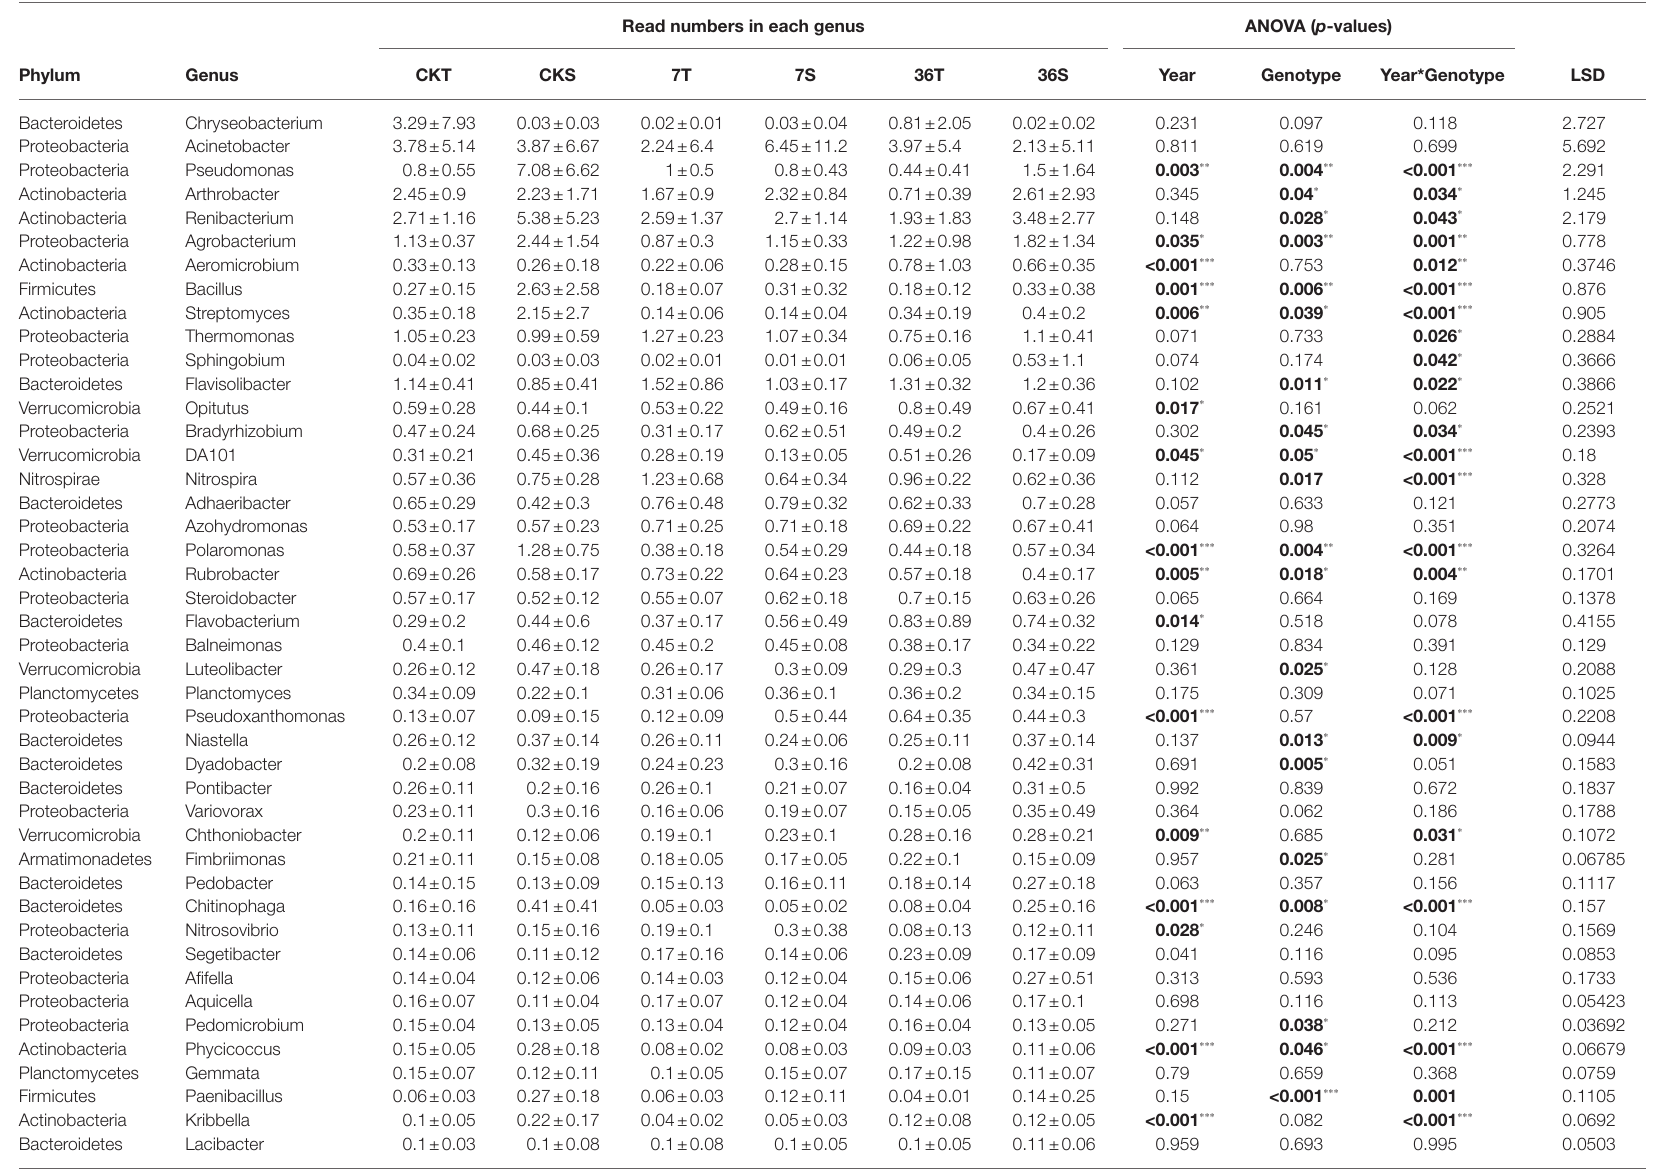
TABLE 3 | Cropping systems, soybean genotypes, and their interactive effects on the relative abundance of bacteria at genus level.